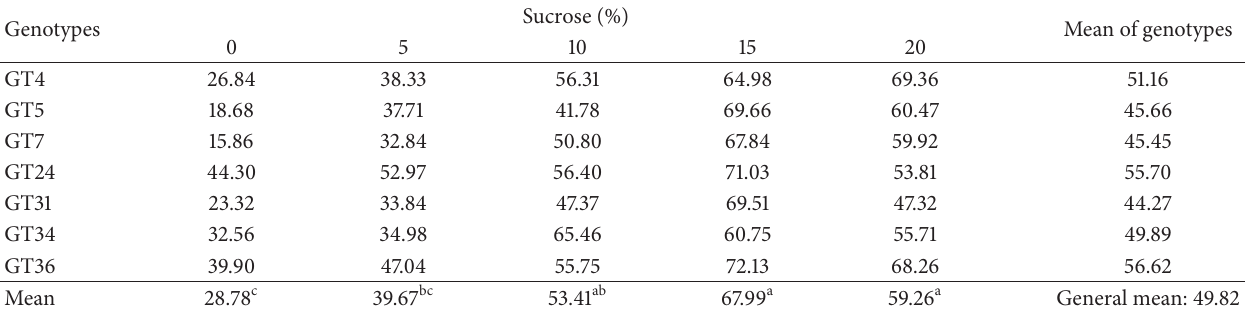
Values with different lower-case letters are significantly different at 𝑃 < 0.05